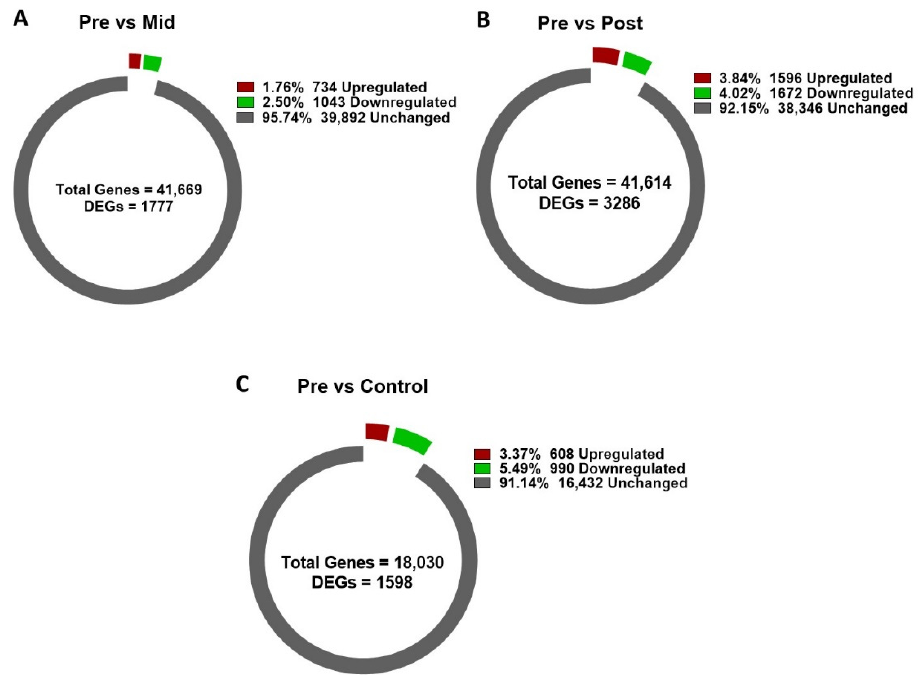
Figure 1. Differentially expressed genes (DEGs) in water dropwort stem under blanched and control conditions. ( A ) Mid − blanched, ( B ) post − blanched, and ( C ) control conditions. Pre − blanching samples were used as a reference for